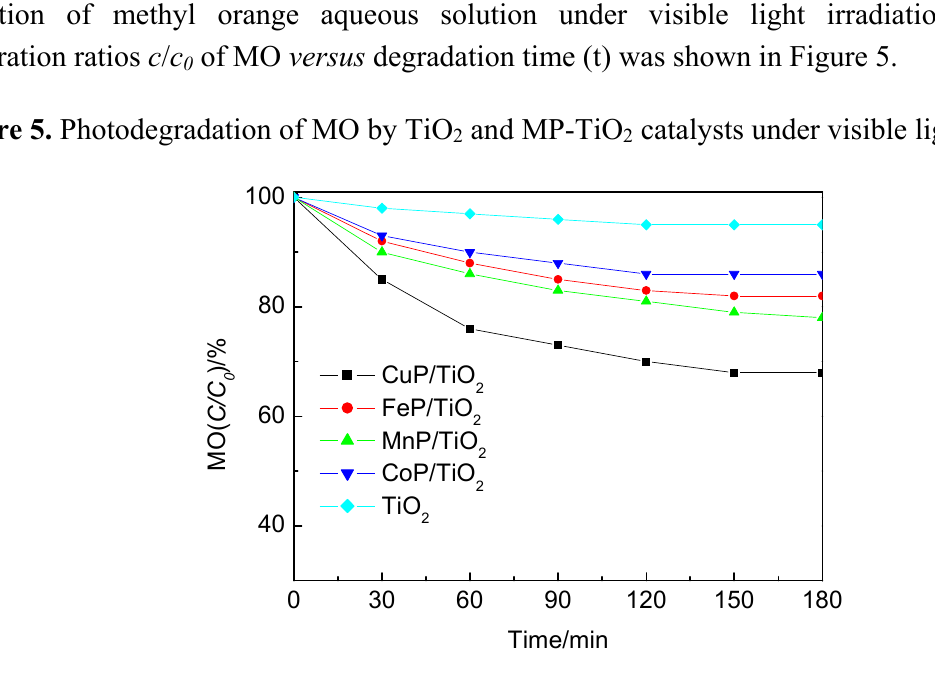
Figure 5. Photodegradation of MO by TiO